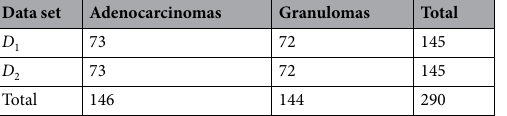
Table 6. Details of the distribution of the granulomas and adenocarcinomas within D 1 and D 2